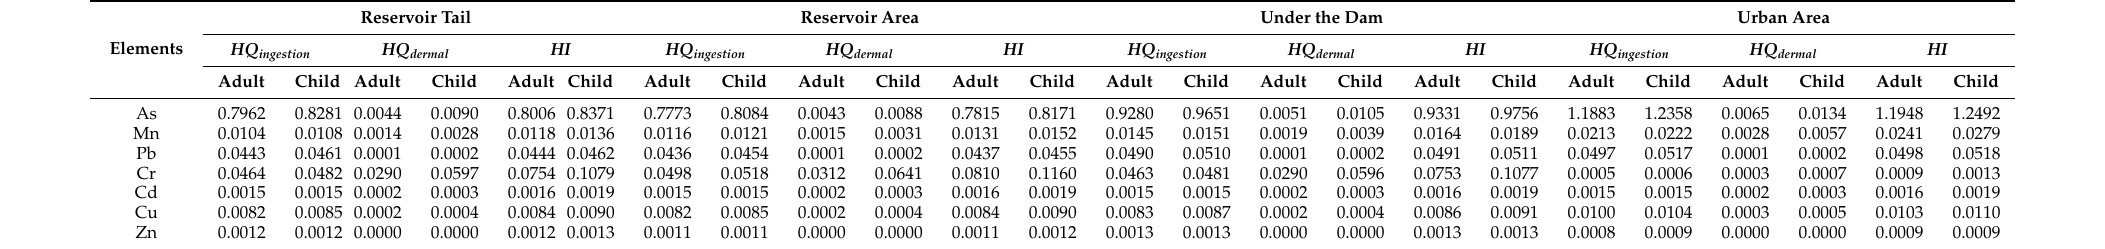
Table 7. Health-evaluation index of trace elements in the main stream of Lancang River during the dry